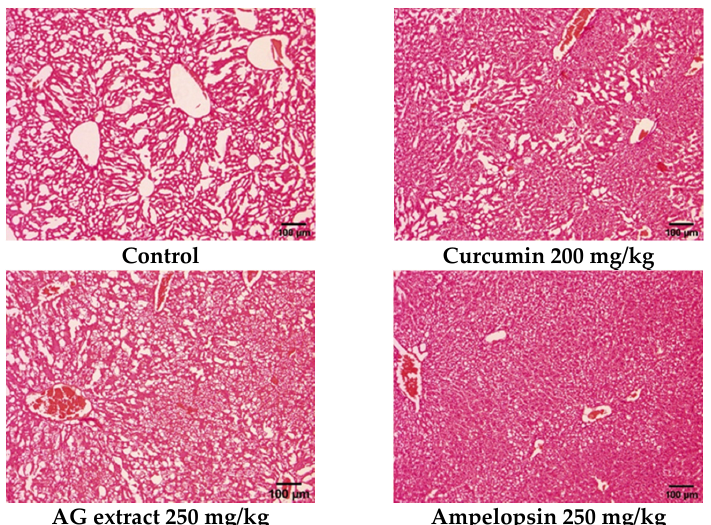
Figure 7. Effects of AG extract and ampelopsin on liver TG and microscopic images of hematoxylin- eosin staining. Each column represents the mean ± SE ( n = 4–5). Data were assessed by a one-way analysis (ANOVA) of variance followed by Dunnett’s method. Asterisks denote significant differences from the control group at * p < 0.05, ** p < 0.01.